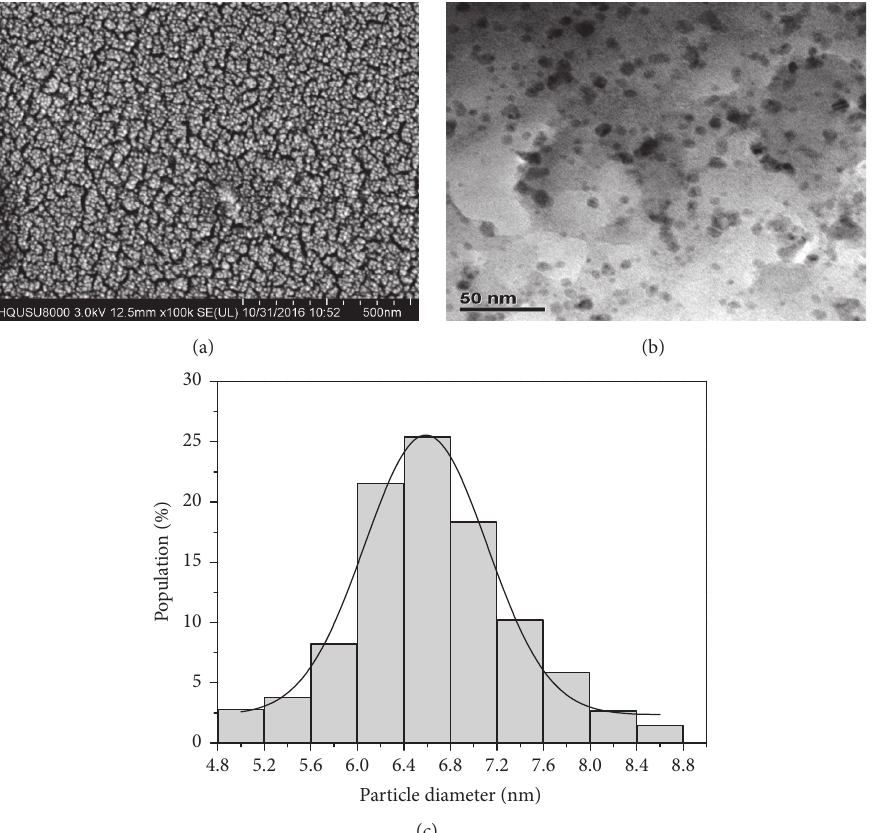
Figure 2: (a) The SEM image, (b) TEM image of the GZVINPs synthesized with Tie Guanyin tea extract, and (c) population distribution of the nanoparticles. Average diameter is 6.58 ± 0.76